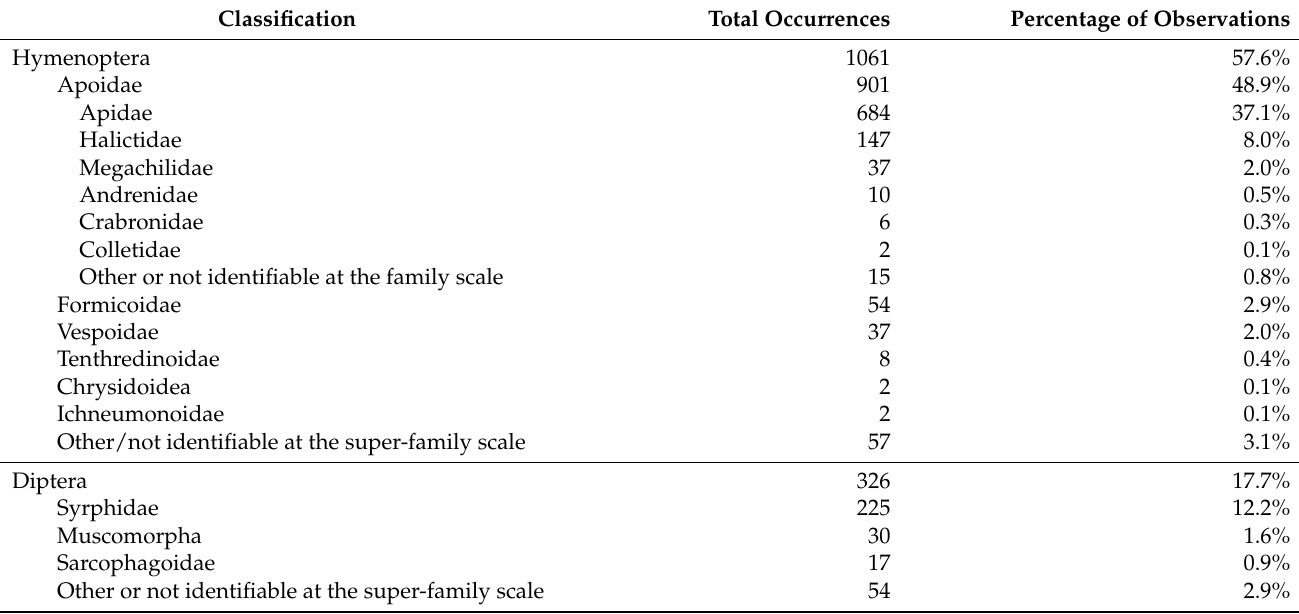
Table 2. Total pollinator occurrences recorded by citizen scientists between 2016 and 2018. The number of occurrences is given for each order, super-family, and family as well as the percentage of observations they